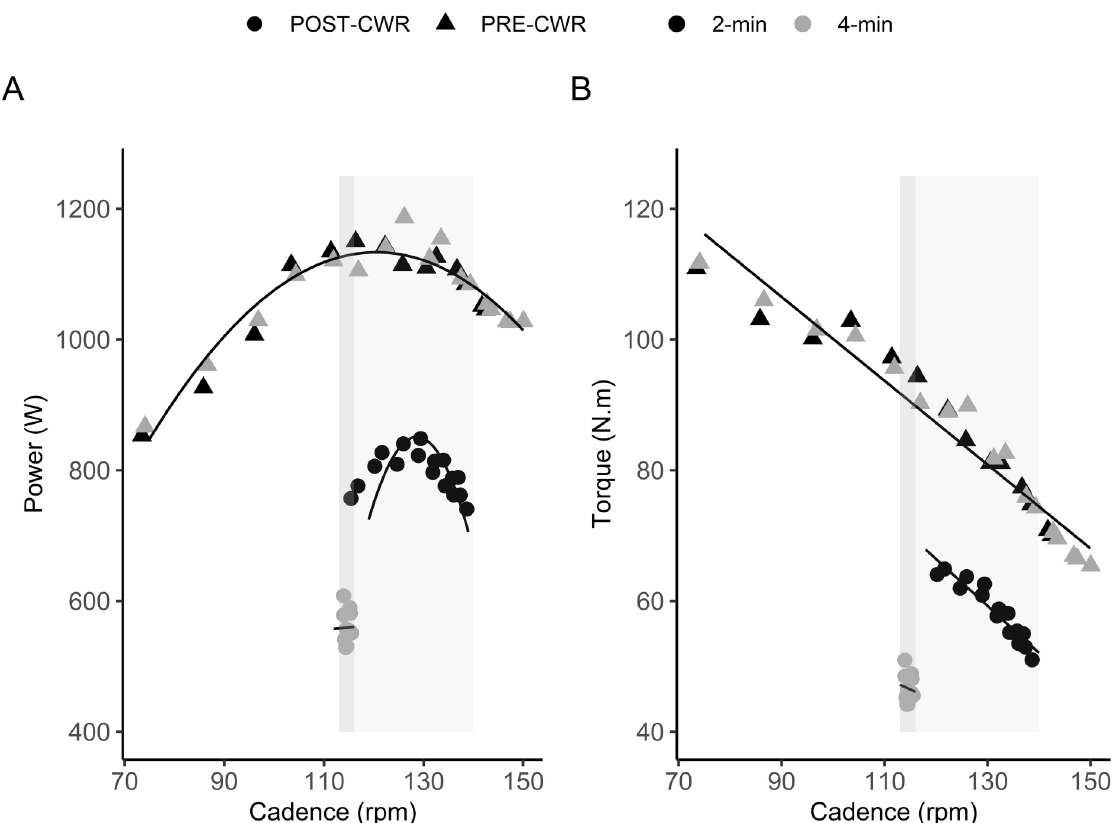
Fig 5. Power-cadence (left) and torque-cadence (right) relationships obtained in the sprints performed before and after the 2-min (black shapes) and 4-min (grey shapes) CWR tests from a representative subject. Triangles represent PRE-CWR sprints and the dots represent POST-CWR sprints. The downward shift of power- and torque-cadence relationships after CWRs demonstrate that power was severely compromised by the increase in CWR test duration. Shaded boxed regions represent the differences between the pedal rate ranges for POST-CWR 2min (lighter grey region) and POST-CWR 4min (darker grey region) zones used for Δ Power ave, PRS calculation.